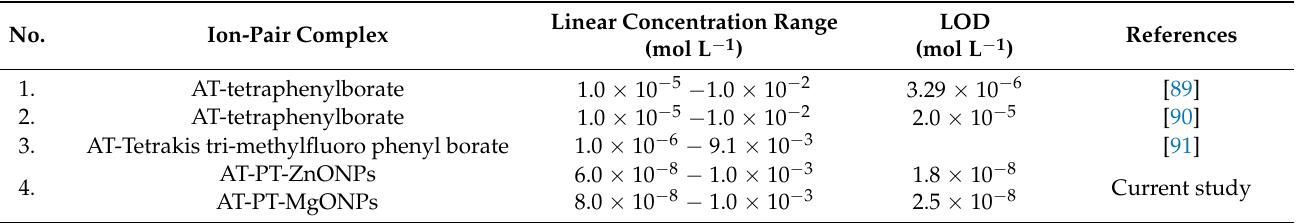
Table 6. The comparative outcomes between the suggested modified AT-PT-ZnONP and AT-PT- MgONP sensors and the previously reported